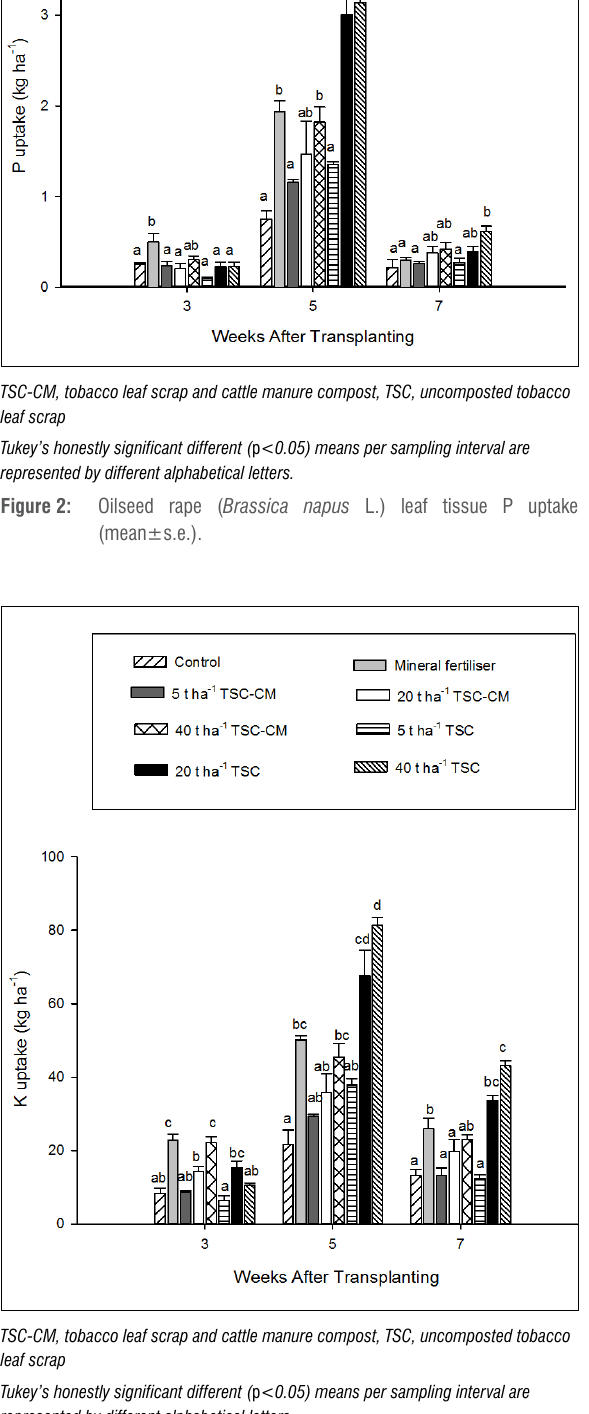
Figure 3: Oilseed rape ( Brassica napus L.) leaf tissue K uptake